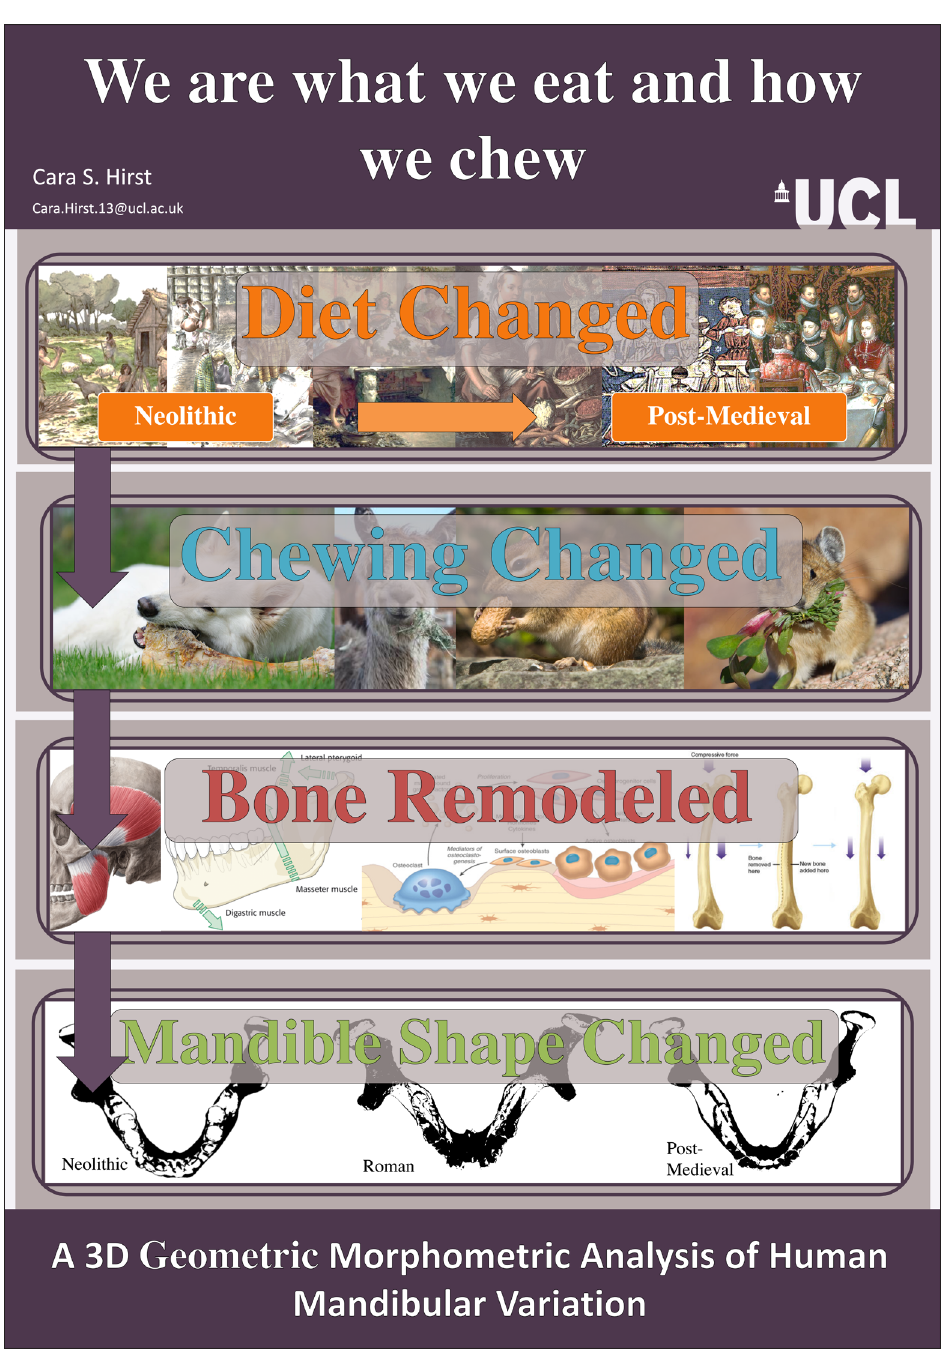
Figure 1: Winning Poster Competition from Cara Hirst, UCL Institute of